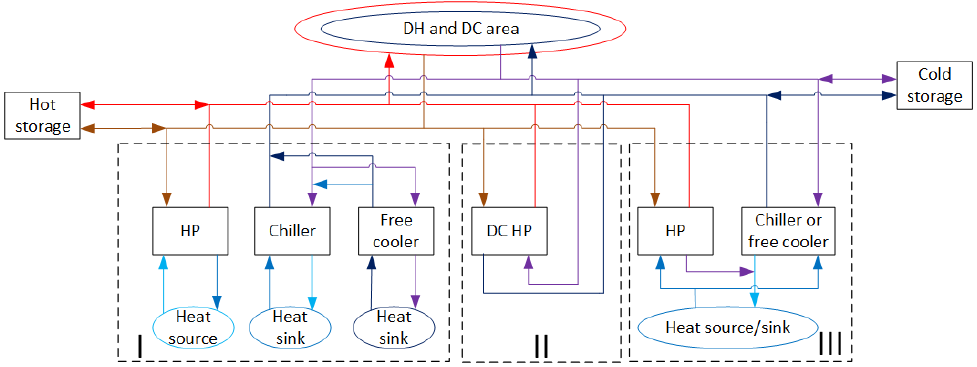
Fig. 1. System layout of supplying DH and DC in different